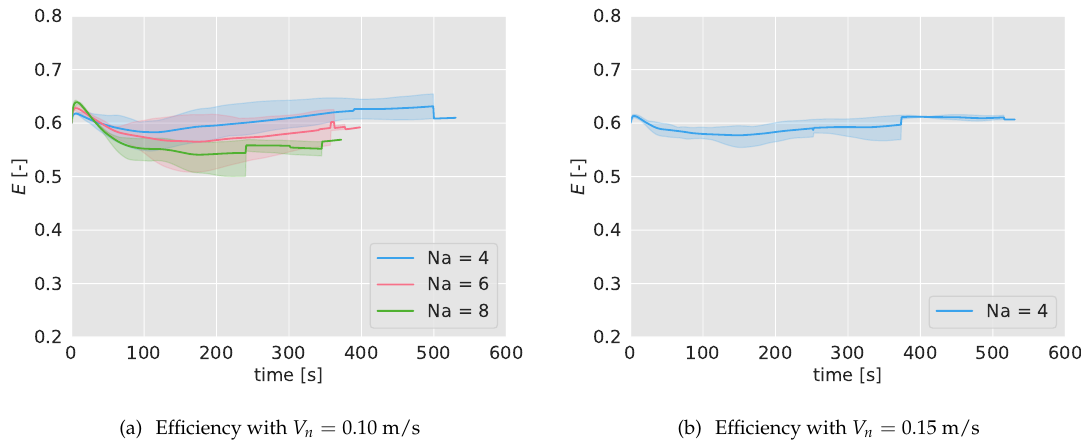
Figure 12. Surveillance efficiency during the experiments with different number of drones, N a = 4,6,8. In ( a ) with a nominal speed of 0.10 m/s; in ( b ), for 0.15 m/s with 4 drones. The colored bands indicate the range within the efficiency lies for the experiments carried